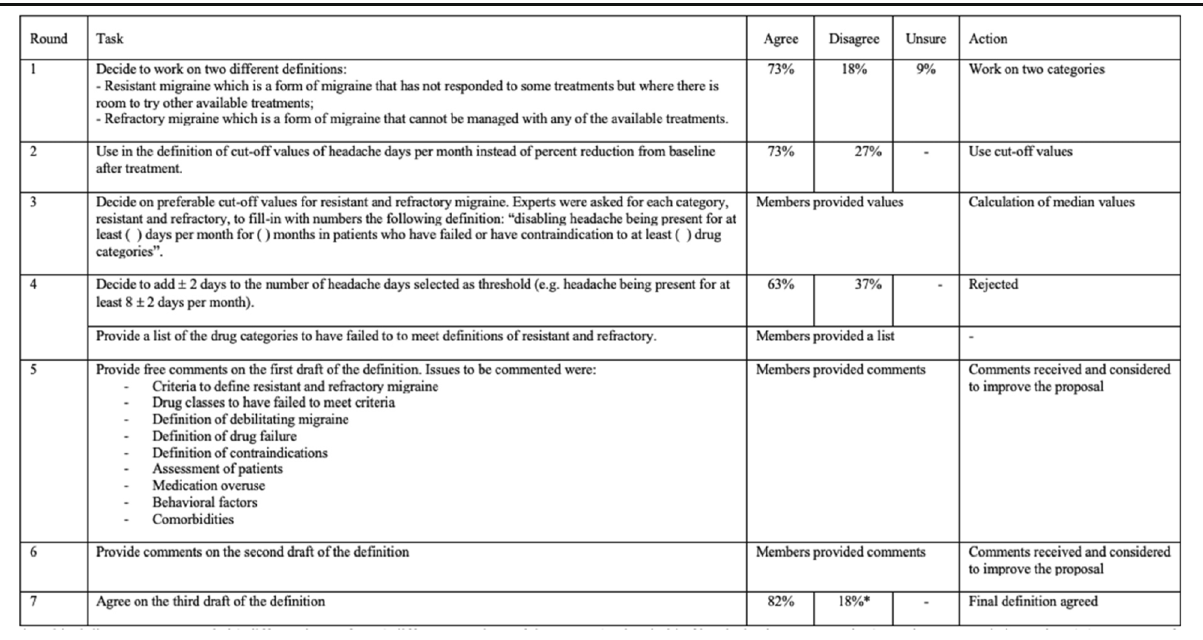
Table 2 Rounds of the consensus process. After each round and before the next one, anonymized results and comments were shared. *Residual disagreement regarded 2 different issues from 2 different members of the group: 1. Threshold of headache days per month: 6 was the suggested alternative; 2 Assessment of patients: no need to be assessed by headache